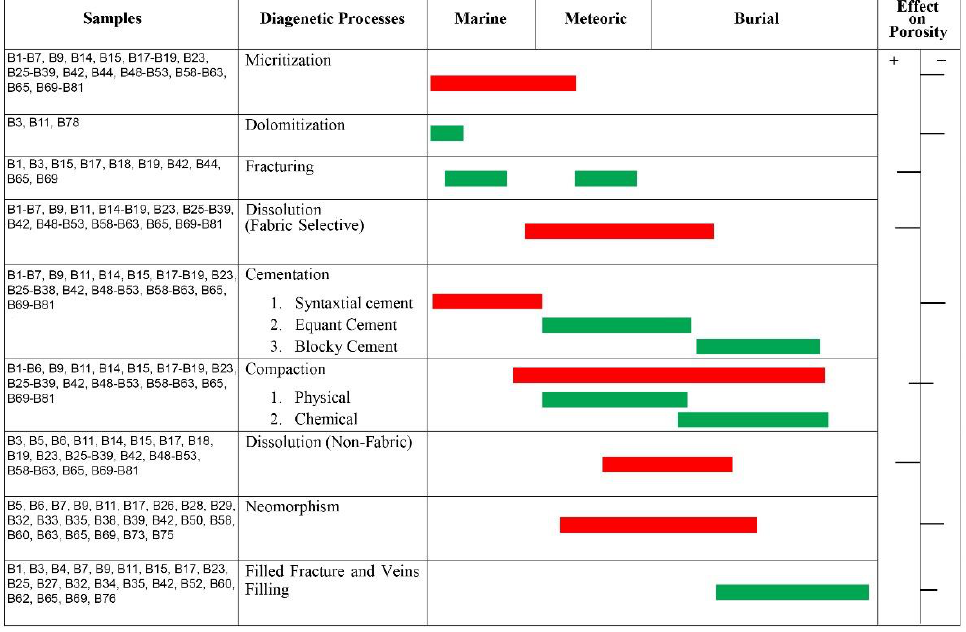
Figure 10. The diagenetic history of K-Pg deposits of Gardiki section based on petrographic obser- vations. Red boxes indicate a strong effect on porosity, and green boxes indicate a low effect on porosity.